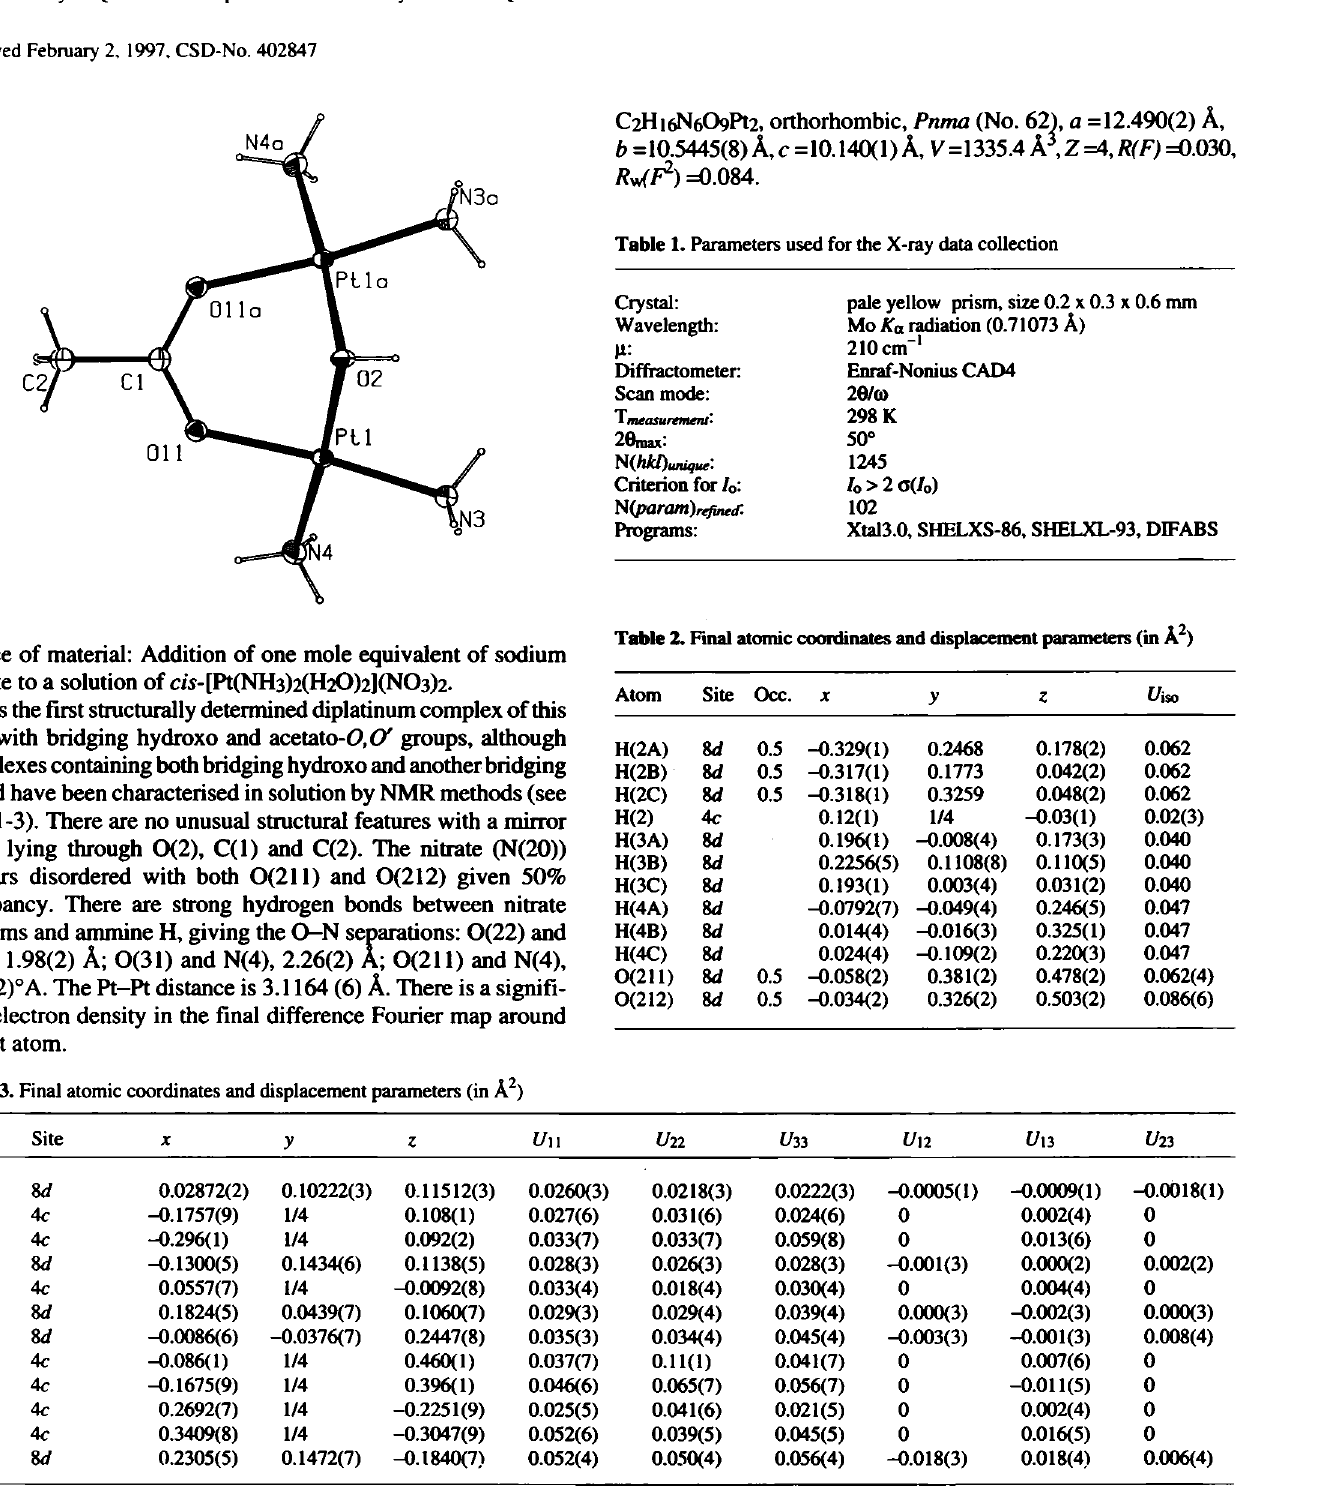
Table 1. Parameters used for the X-ray data collection Crystal: